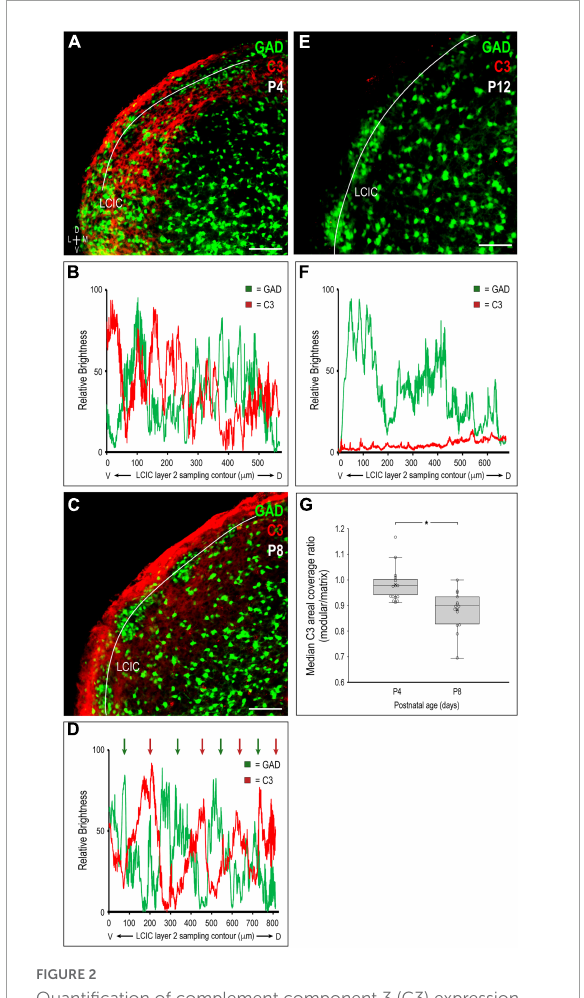
FIGURE2 Quantification of complement component 3 (C3) expression patterns with respect to the emerging lateral cortex of the inferior colliculus (LCIC) compartmental structure. Multichannel region of interest (ROI) contour sampling of LCIC layer 2 modular fields at P4 (A) , P8 (C) , and P12 (E) with corresponding glutamic acid decarboxylase (GAD) (green) and C3 (red) expression profiles (B,D,F) . Although C3 signal fluctuations are evident at P4, they still appear largely unorganized with respect to emerging GAD-positive modules (B) . By P8, clear periodicities are observed for both channels with waveforms that are consistently out-of-phase with each other [ green and red arrows in (D) ]. Such spatial offset confirms modular-specific C3 loss at this age, with strong expression persisting throughout the encompassing matrix. By LCIC critical period closure at P12, C3 expression is barely detectable (F) , suggesting its clearance from both LCIC compartments. Box and whisker plots comparing median compartmental areal coverage ratios at critical period stages P4 and P8 (G) . Their vertical separation demonstrates significant differences in modular C3 expression at these ages (* p < 0.001). Note that the disjoint P4 and P8 boxes indicate that 3/4 of the P4 ratios are above 3/4 of the P8 ratios. P4 values clustered about or just below 1 suggest a transition at this age from homogeneous C3 LCIC expression seen earlier, to the beginnings of selective C3 disappearance within modular confines. Markedly lower P8 values quantitatively indicate continued modular-specific C3 loss. Horizontal lines within boxes represent medians; X’s within boxes represent means. Scale bars in (A,C,E) = 100 µ